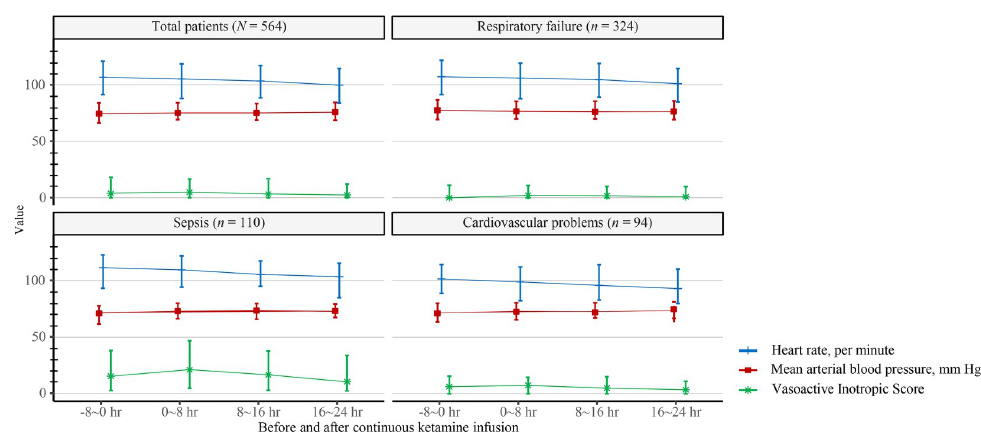
Fig 2. Hemodynamic trends during continuous ketamine